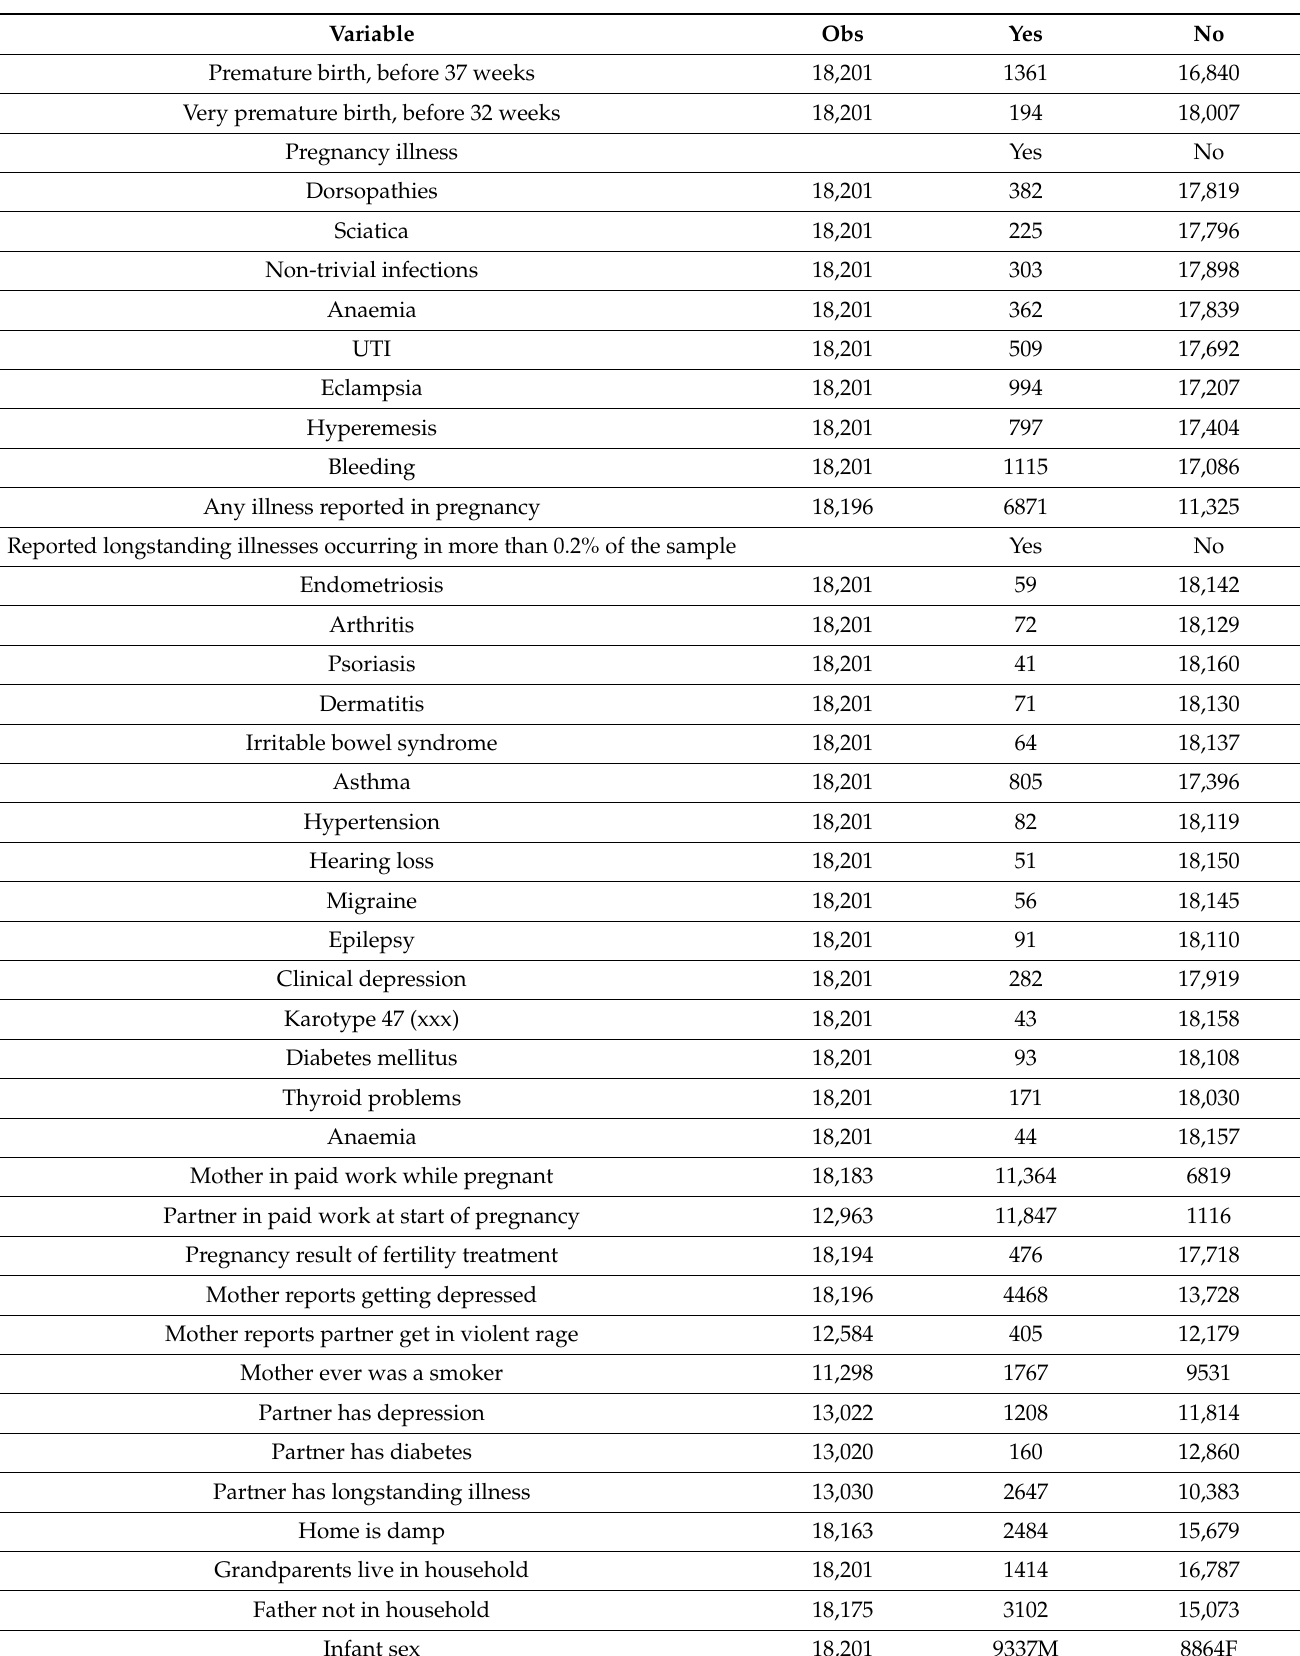
Table 1. Descriptive statistics for the outcome and binary